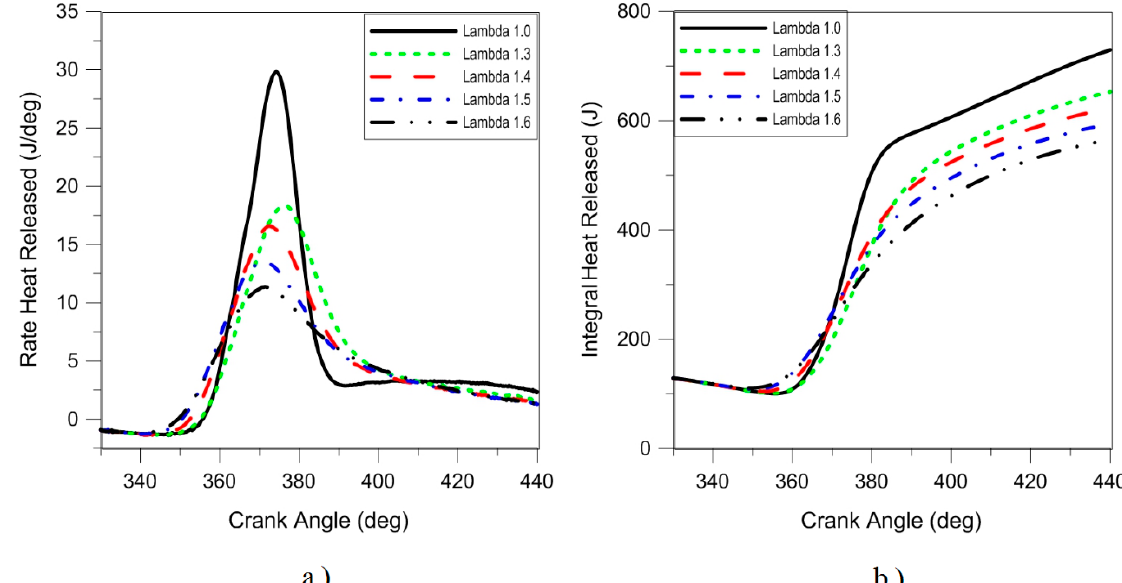
Figure 7. Rate of heat release ( a ) and integral heat released; ( b ) traces averaged over 200 consecutive cycles for each tested air–fuel ratio.